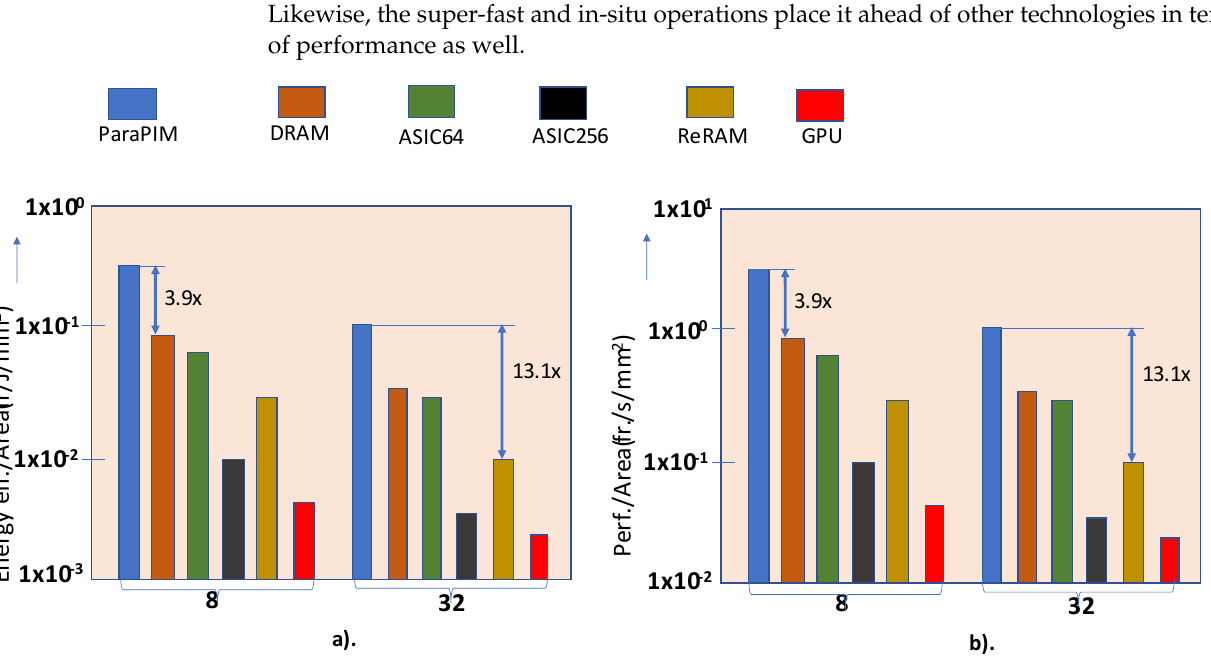
Figure 29. Comparison results for ( a ) normalized energy efficiency; ( b ) normalized performance of different memory architecture accelerators [14].